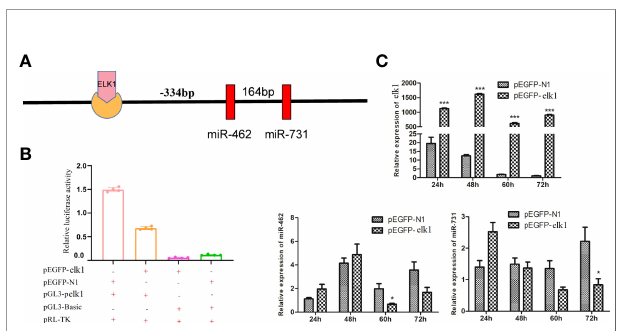
FIGURE 2 | Transcription factor ELK1 can bind to the miR-462-731 cluster promoter fragment and regulate the expression of miR-462-731. (A) Predicted binding site of ELK1 to the promoter fragment of the miR-462-731 cluster. (B) CIK cells were transfected with the recombinant plasmids pEGFP-elk1 or pEGFP-N1, along with pGL3-pelk1 for 48 h, and the luciferase activity was determined. (C) Expression pro fi les of elk1 miR-462 and miR-731 in C.Idella Kidney cells (CIK) cells at 24, 48, 60 and 72 h following transfected pEGFP- elk1 or pEGFP-N1. All values represent the mean ± SD of three independent experiments. Asterisks indicate signi fi cant differences (*p < 0.05, ***p <